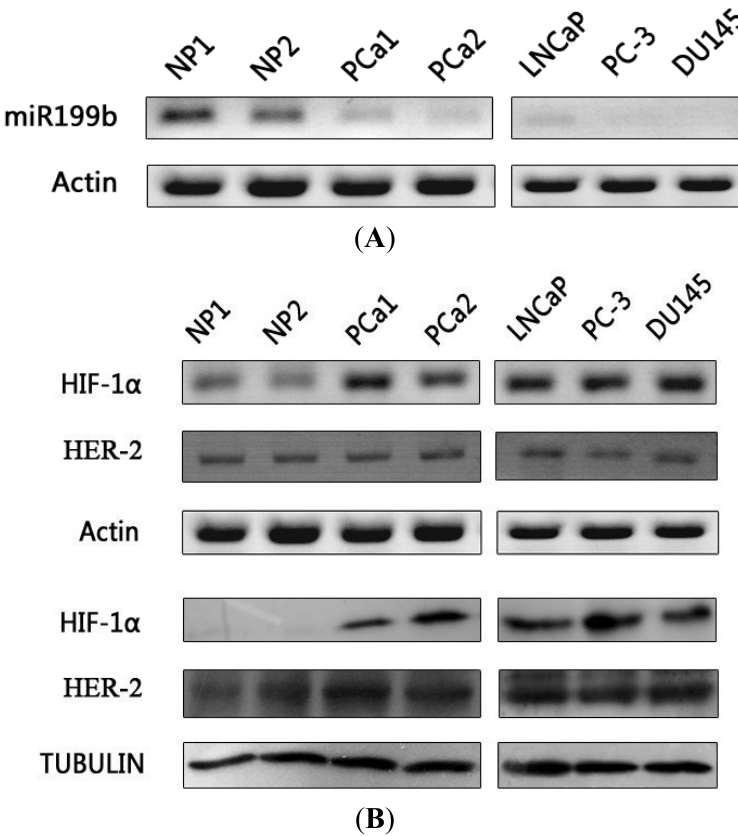
Figure 1. miR199b and HIF-1 α expression in normal prostate (NP), prostate cancer tissue (PCa), and prostate cancer cell lines. ( A ) stem-loop RT-PCR analysis (with actin as control) showing differential expression of mature miR199b in normal prostate tissue versus prostate cancer, and prostate cancer cells LNCaP, PC-3, and DU145; ( B ) in contrast to miR199b, HIF-1 α mRNA (top, RT-PCR, same actin control as for A) and protein (bottom, Western blotting, tubulin as control) were significantly higher in prostate cancer tissue and cells than in normal prostate